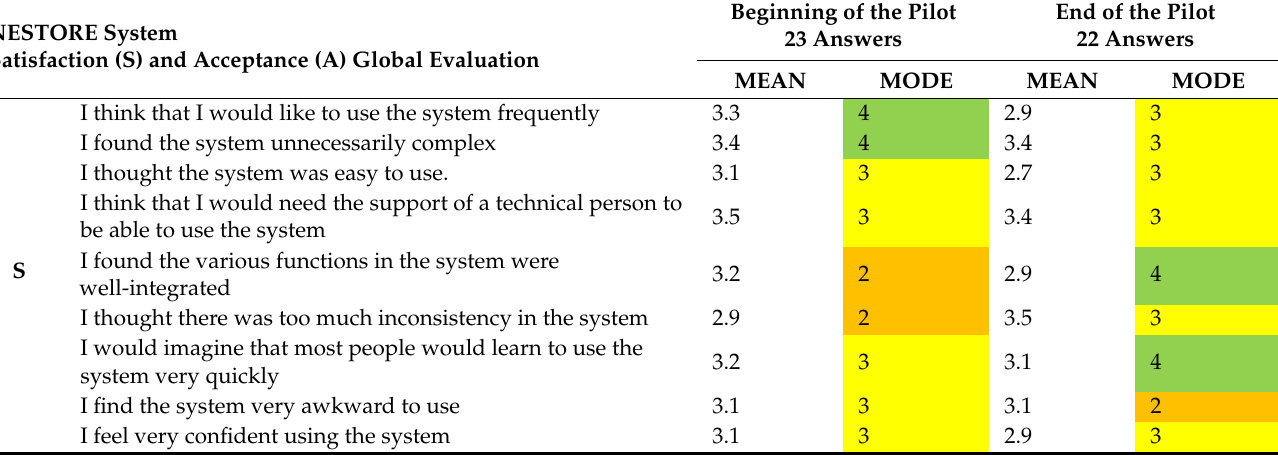
Table 4. The results of the SUS/TAM surveys, answered by the users at the beginning and the end of the